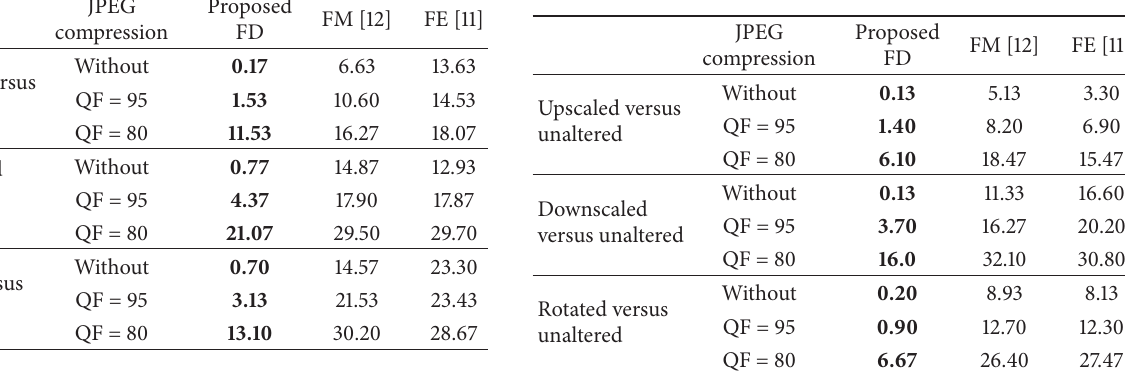
Table 3: 𝑃 𝑒 (%) of each detector on detecting forged resampled images from unaltered images. Here “without” means without applying JPEG compression on test images. The best result is displayed by bold